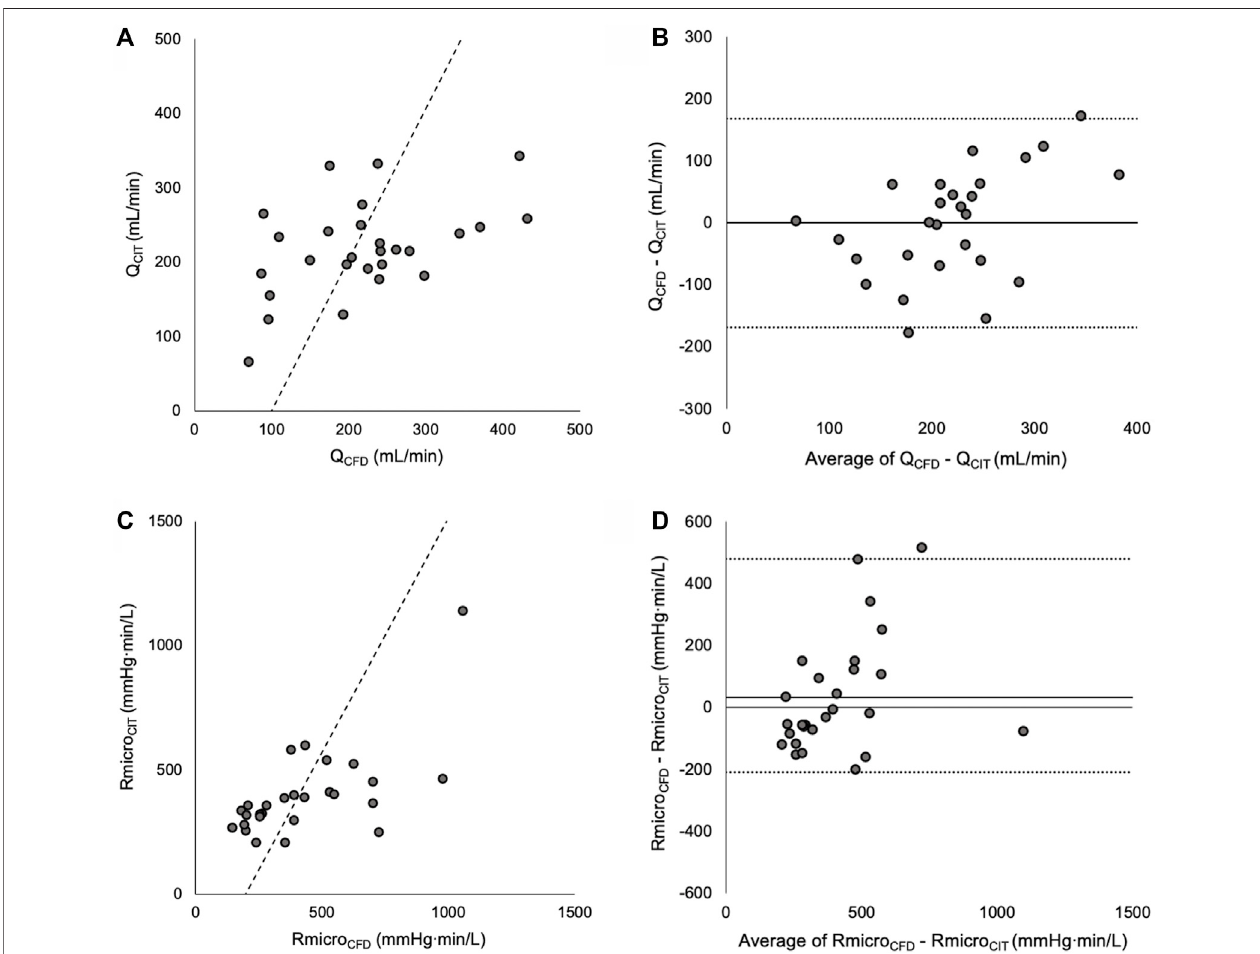
FIGURE 2 | (A) Correlation between Q CFD and Q CIT (Line of best fi t is Passing and Bablok). (B) Bland Altman plot showing mean bias and 95% limits of agreement betweenQ CFD andQ CIT . (C) ScatterplotshowingcorrelationbetweenRmicro CFD andRmicro CIT . (D) BlandAltmanplotofreverse-transformeddata,showingmeanbias and 95% limits of agreement.